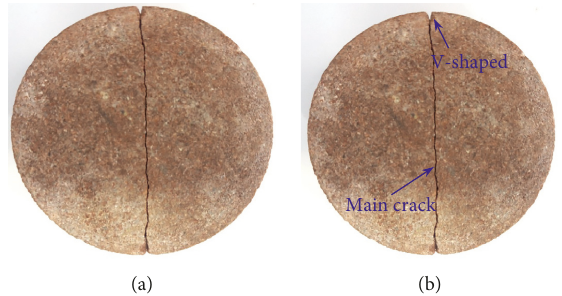
Figure 11: The failure mode of specimens under plate loading. (a) No. 1-11. (b) No.